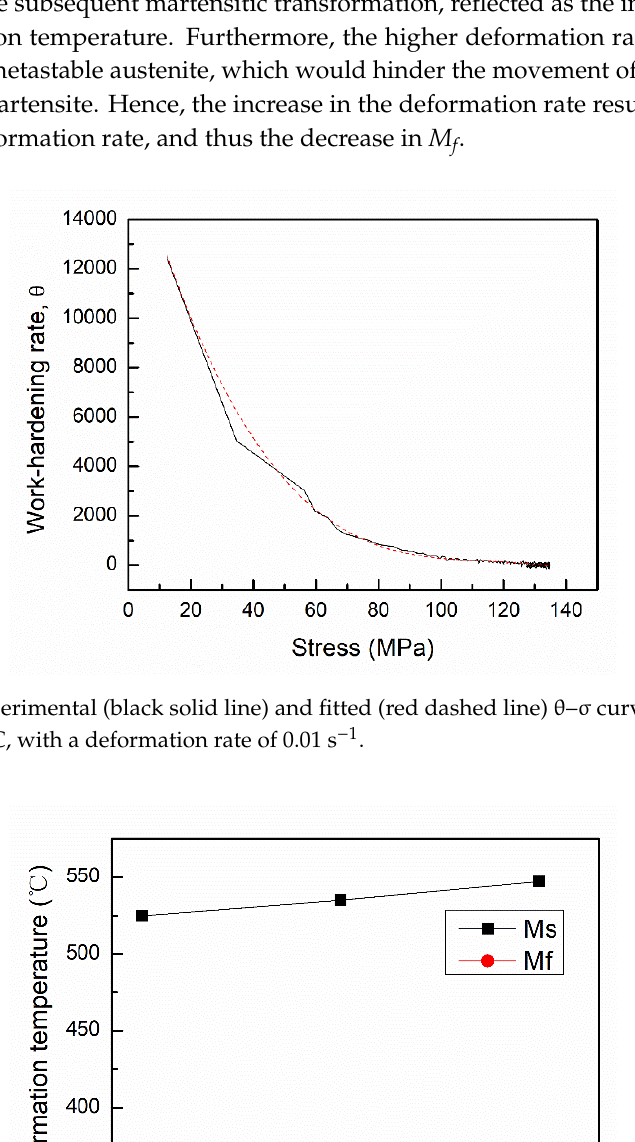
Figure 19. Vickers hardness of the low-carbon ferritic stainless steel samples with the different strain rates. 4. Conclusions In this paper, the effects of the deformation temperature, the deformation reduction and the deformation rate on the microstructures, phase transformation behaviors, stress–strain curves and mechanical properties were investigated. The main conclusions are as follows: (1) The increase in deformation temperature promotes the formation of the fine equiaxed DSIT ferrite and suppresses the martensitic transformation. The higher deformation temperature results in a lower starting temperature for martensitic transformation. When the deformation temperature reaches 900 °C, the stress–strain curve shows an obvious softening phenomenon, and the hardness decreases to minimum. (2) The increase in deformation can effectively promote the transformation of DSIT ferrite, and decrease the martensitic transformation rate, which is caused by the work hardening effect on the metastable austenite.